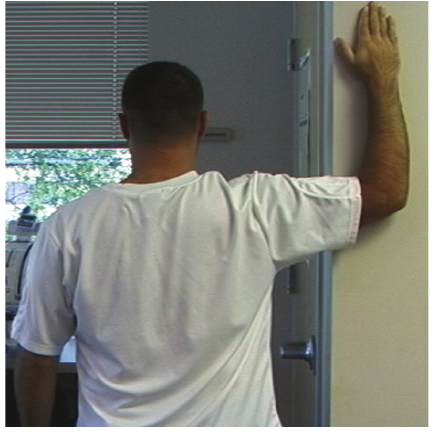
Figure 3: Corner